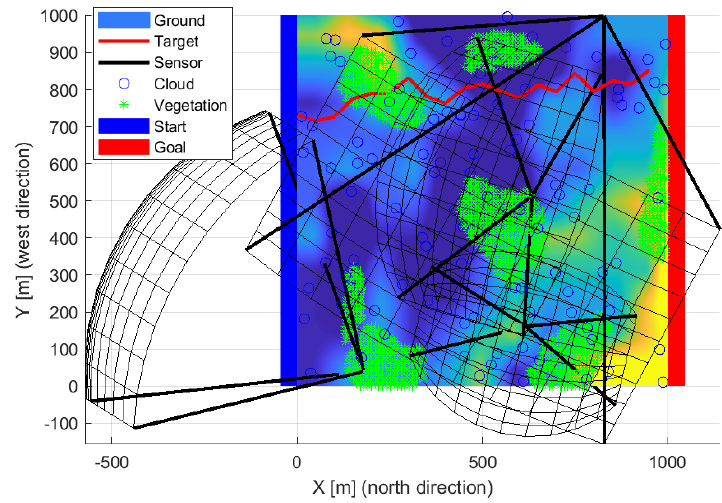
Figure 14. The solution in the case of the four sensors from above.